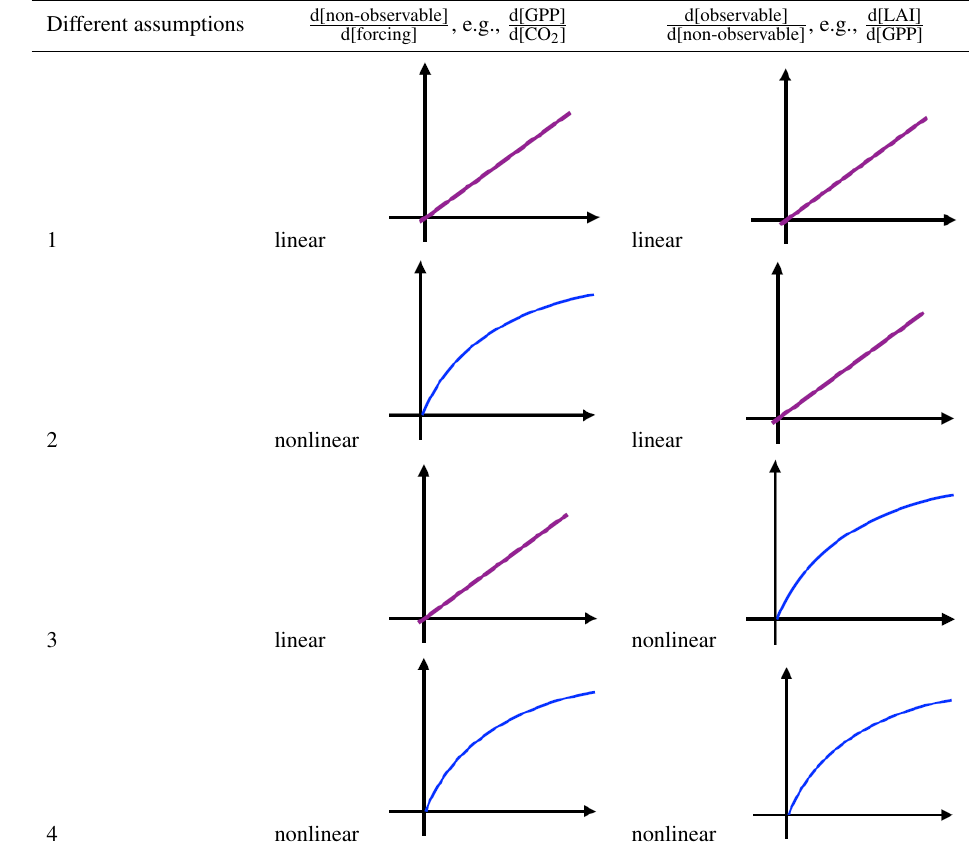
Table A1. Overview of four possible cases of interaction between forcing, nonobservable, and observable identified in the thought experi- ment: all linear, all nonlinear, and two mixed